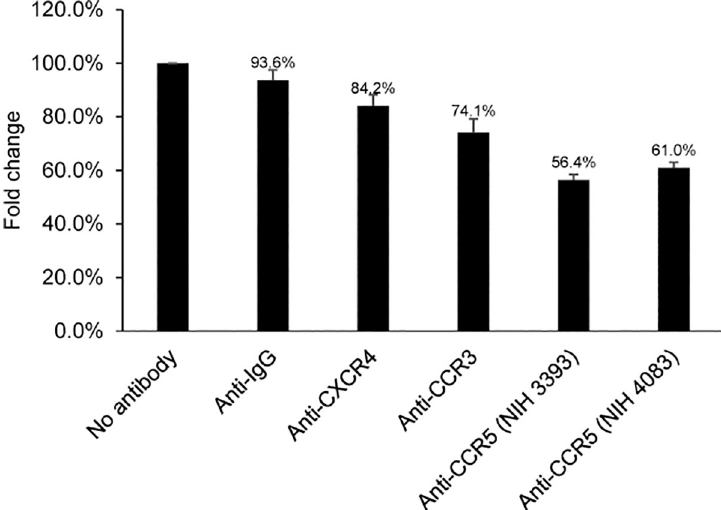
Fig 3. HCV core protein production after antibody treatment. Huh7.5 JFH1 cells were exposed to a 1:100 dilution of anti-IgG (RD IC002A), anti-CXCR4 (NIH 4083), anti-CCR3 (NIH 4923), anti-CCR5 (NIH 3933), or anti-CCR5 (NIH 4083). HCV core protein production was quantified by ELISA in supernatants at day 1 post-incubation. All comparisons to anti-IgG significant (p < 0.05) using comparison of least square means based on a one-way